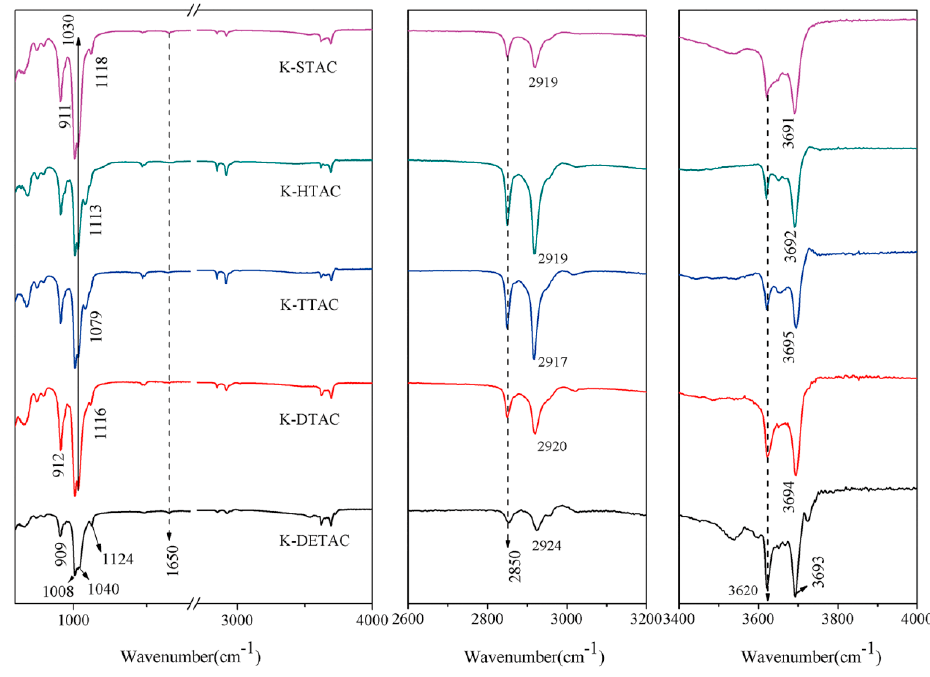
Figure 7. FTIR vibration spectra of kaolinite/quaternary ammonium salts intercalation compounds (K-Qas).